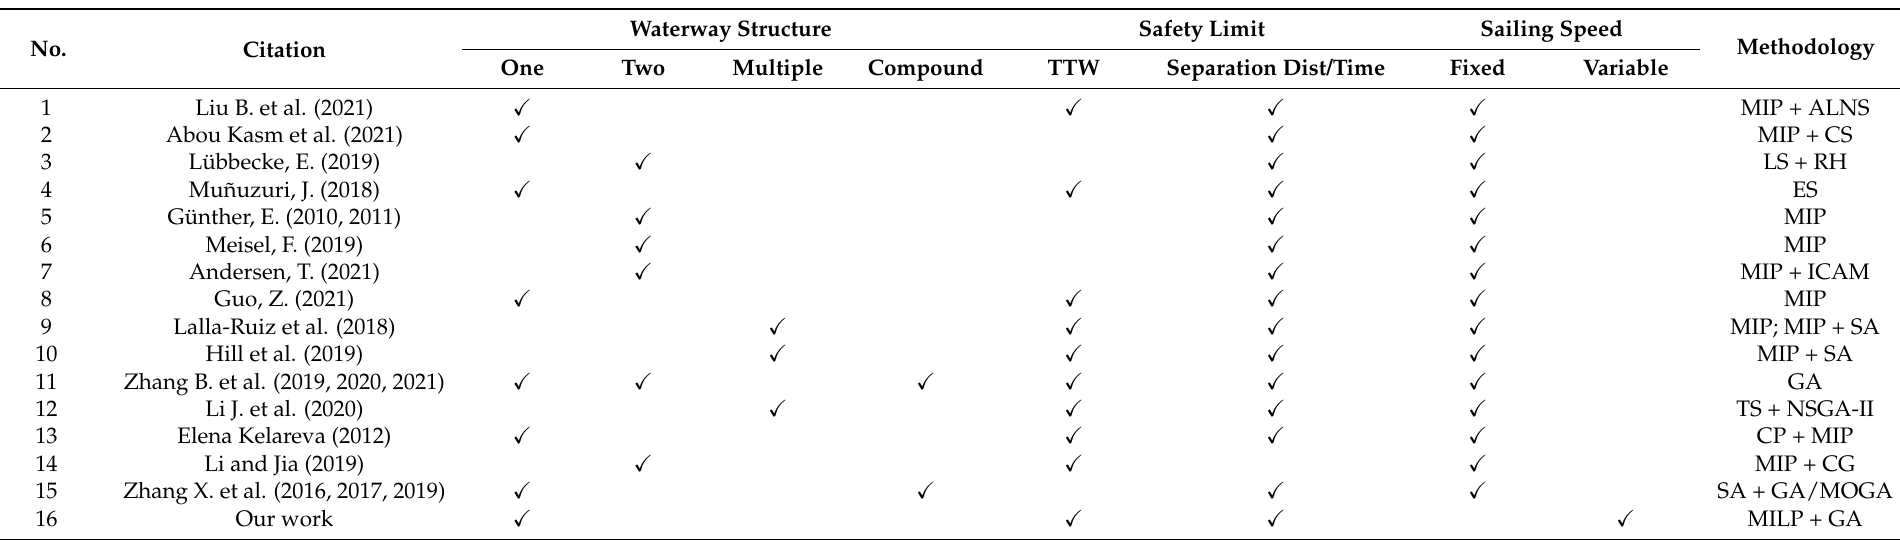
Table 1. Contributions to related studies on the